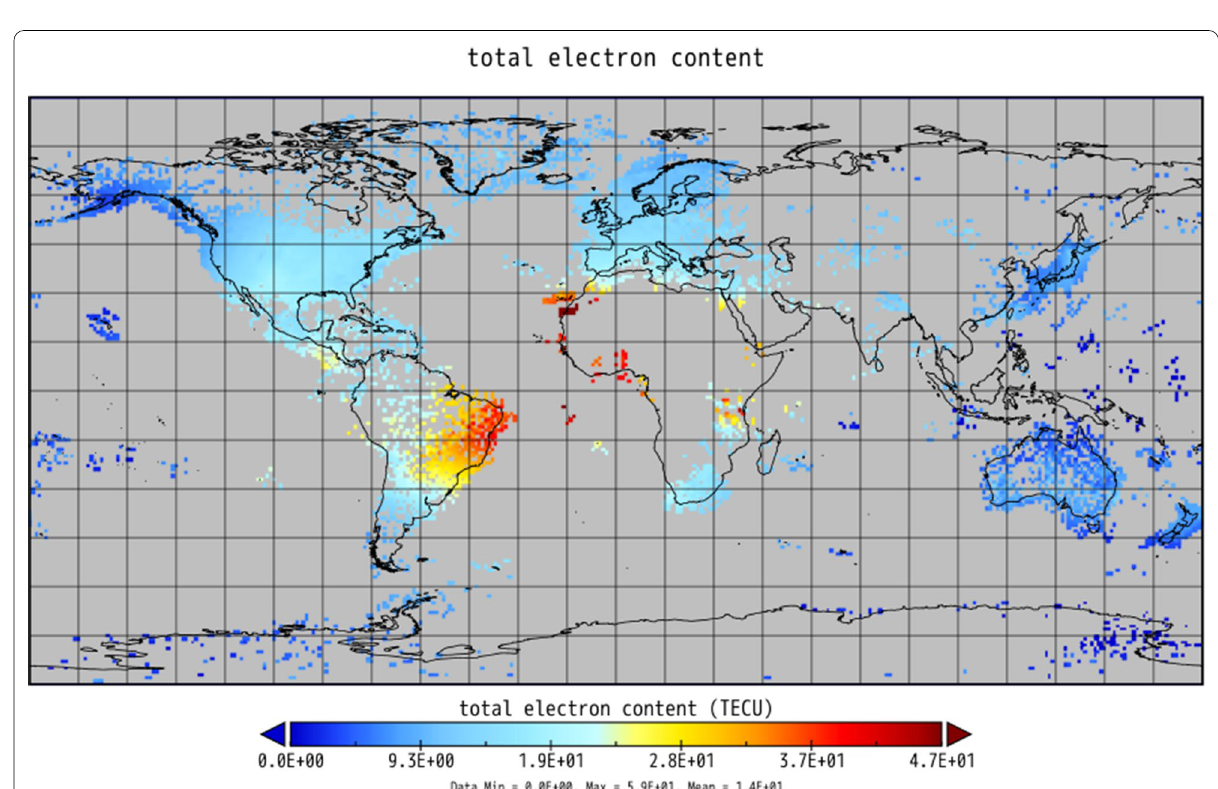
Fig. 3 Distribution of TEC observed by global TEC (Drawing-TEC) at X9.3 class flare (12 UT). The European region was in the daytime at the time of the flare, and has sufficient